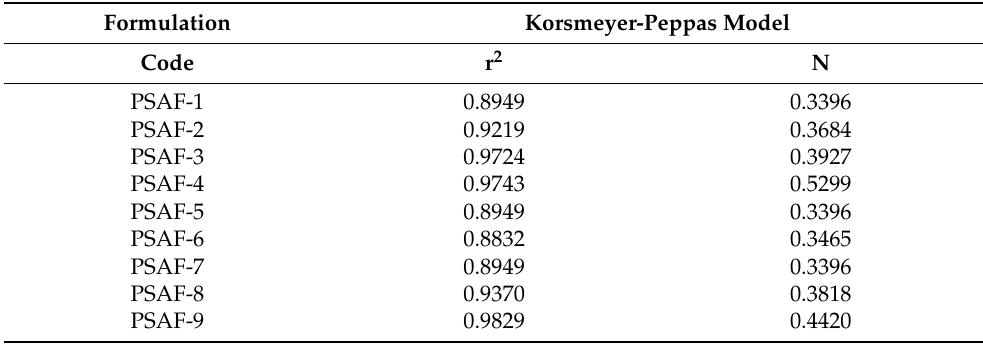
Table 2. Kinetic modeling release of KT from SPSPAA hydrogels.